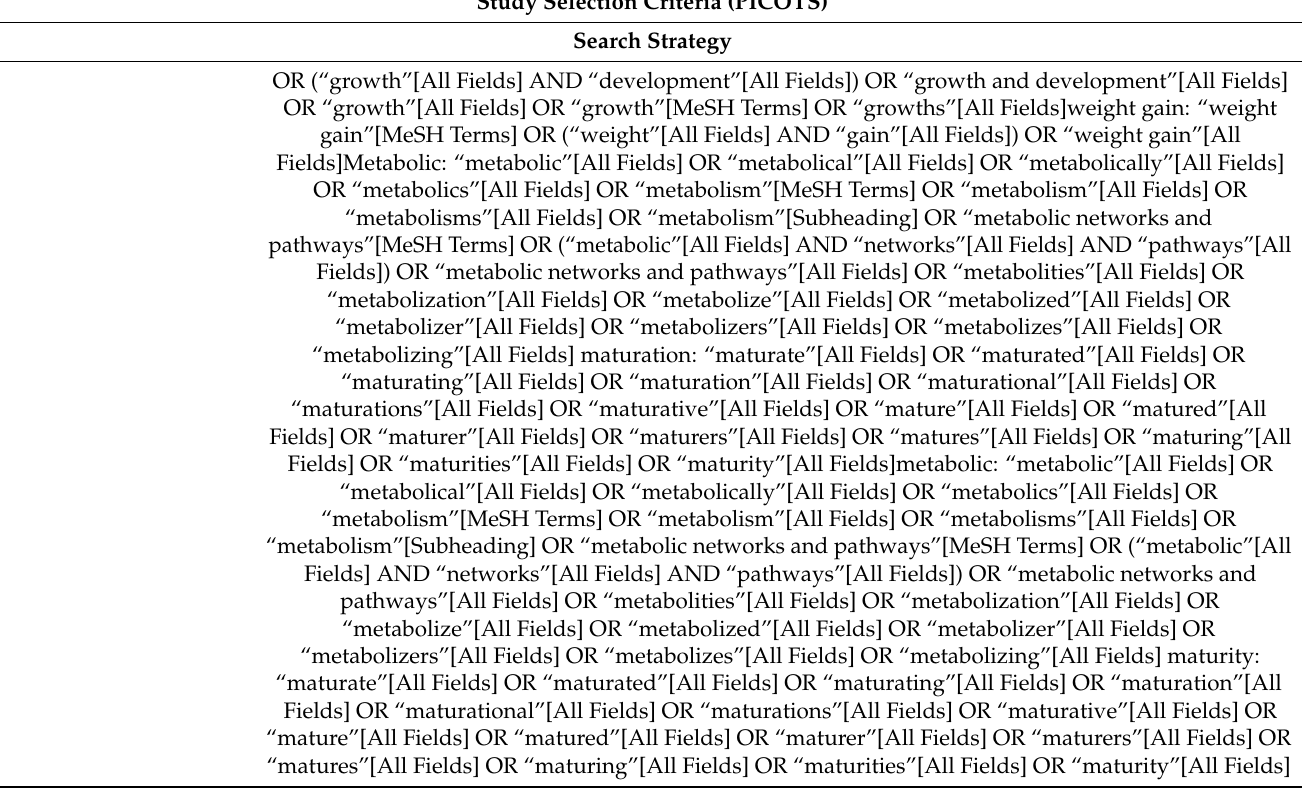
Table A2. Cont. Study Selection Criteria